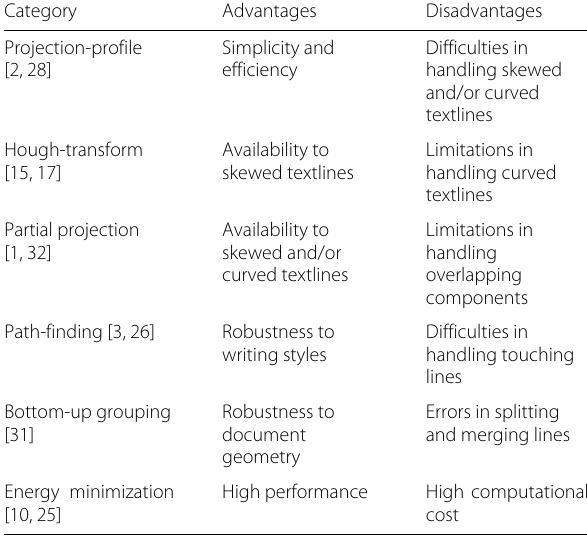
Table 1 Textline detection methods for handwritten